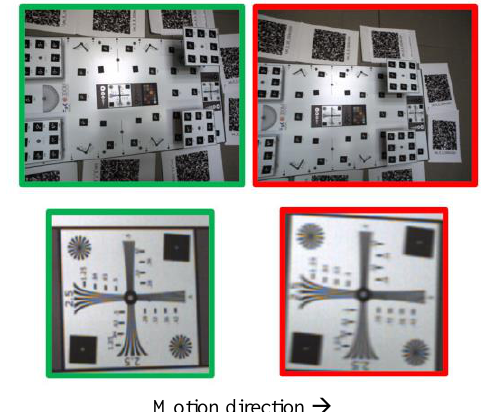
Motion direction → Figure 7. Resolution patterns extracted from two images captured while the speed was within the allowed range (left in green) and while a red warning was shown on the display (right in red). In this case the 2mm target GSD cannot be reached because of the introduced motion blur.